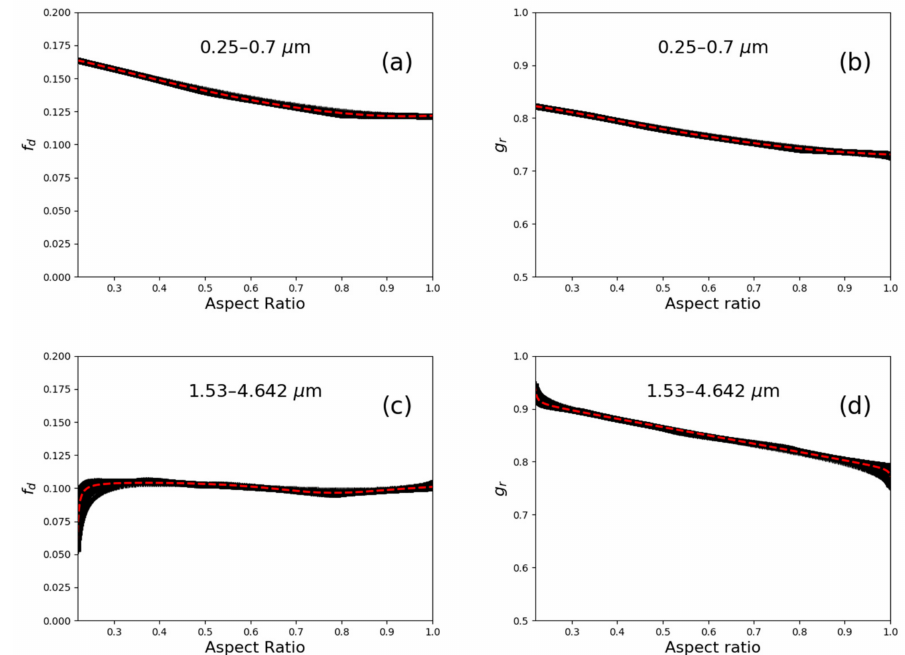
Figure 3. Parametrizations for delta fraction ( a , c ) and rough surface particle asymmetry factor ( b , d ). The upper and lower rows refer to wavelengths of 0.25–0.7 µ m ( a , b ) and 1.53–4.642 µ m ( c , d ) intervals respectively. The black line is composed of 7500 individual points, each represents a different PSD, and the red dashed line denotes the parametrization fit